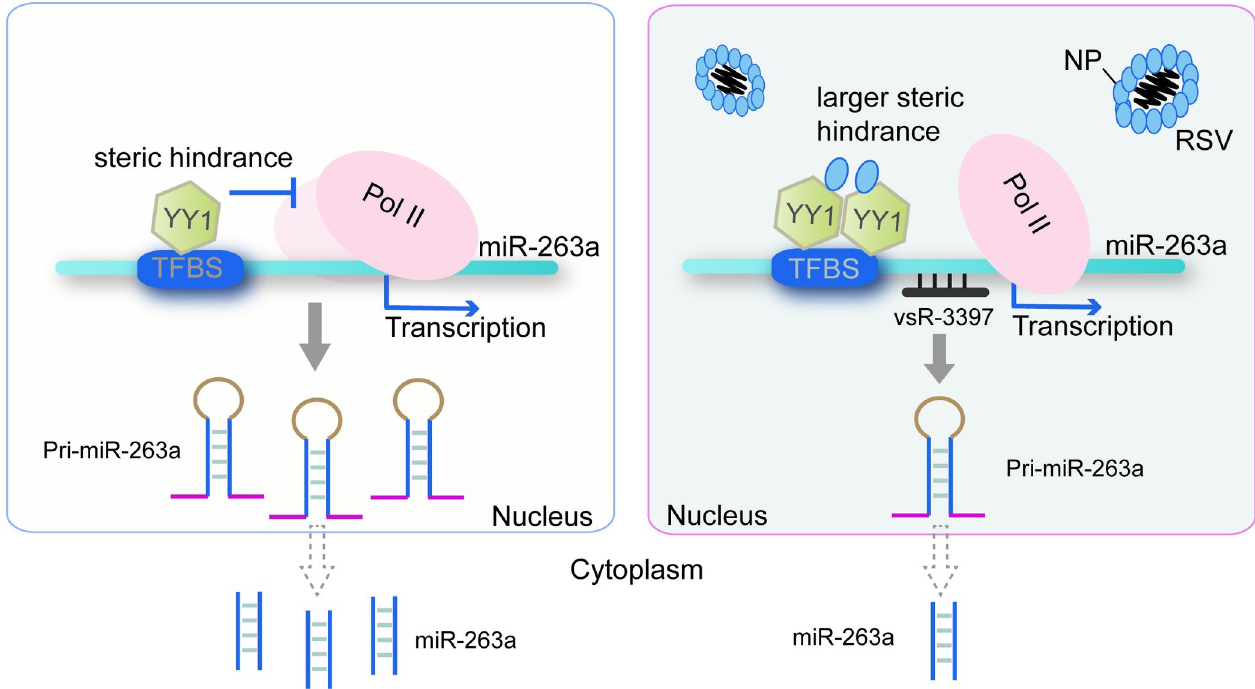
Fig 7. Model of the regulatory mechanisms for miR-263a by RSV. The NP of RSV binds the transcription factor YY1 to promote its inhibitory effect on miR-263a transcription probably due to enlargement of the steric hindrance to the binding of Pol II to the promoter with more YY1. At the same time, RSV- derived small RNA, vsR-3397, directly targets the promoter region of miR-263a to downregulate miR-263a transcription. TFBS, transcription factor binding site.